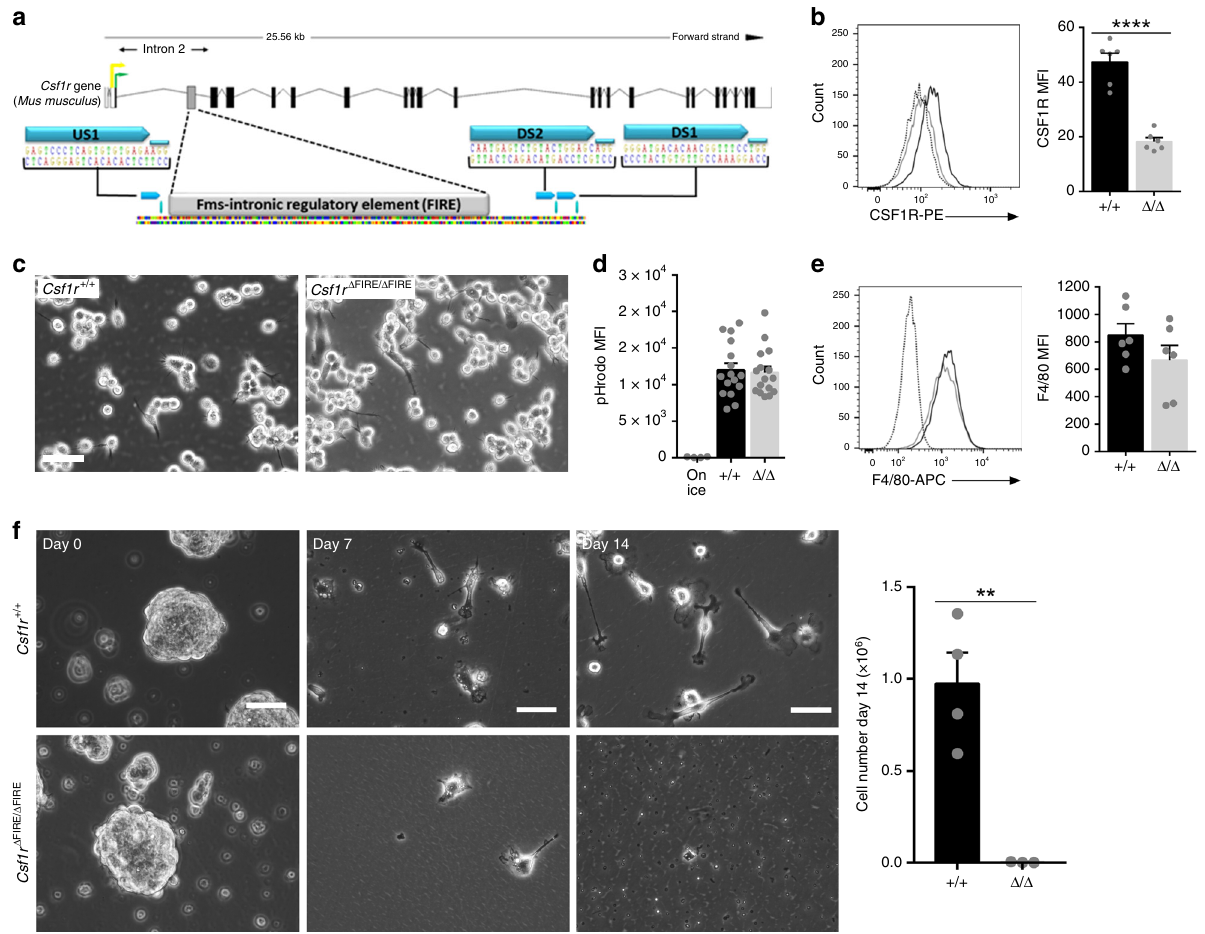
Fig. 1 FIRE deletion reduced CSF1R expression and prevented macrophage differentiation. a Schematic of Csf1r gene and location of gRNAs (US1, DS1, DS2), targeting FIRE. Protospacer adjacent motifs (PAM) are located to the right of each gRNA. Black boxes = coding exons, white boxes = untranslated regions, lines connecting exons = intronic sequences, yellow and green arrows = trophoblast/osteoclast promoter and macrophage transcription start sites, respectively. b Flow cytometry analysis of total CSF1R in fi xed and permeabilized RAW 264.7 cell clones. Histograms are representative of three clones per genotype, from two repeat experiments in duplicate. MFI median fl uorescence intensity, black line = + / + , gray line = Δ / Δ , dotted line = isotype control. P